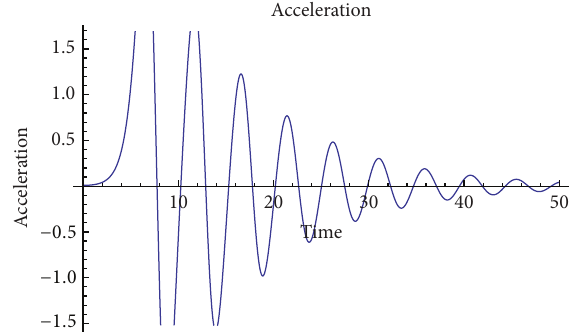
Figure 8: The chaotic but periodic plot of real and complex temperature for 𝜀 = 0.0001, 𝐵 = 40, ] = 0 .